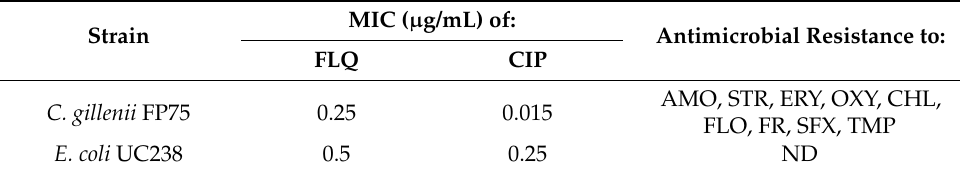
Table 3. Antimicrobial resistance patterns and minimum inhibitory concentrations (MICs) of Cit- robacter gillenii FP75 and Escherichia coli UC238. MIC ( µ g/mL) of: Strain Antimicrobial Resistance to: FLQ CIP AMO, STR, ERY, OXY, CHL, C. gillenii FP75 0.25 0.015 FLO, FR, SFX, TMP E. coli UC238 0.5 0.25